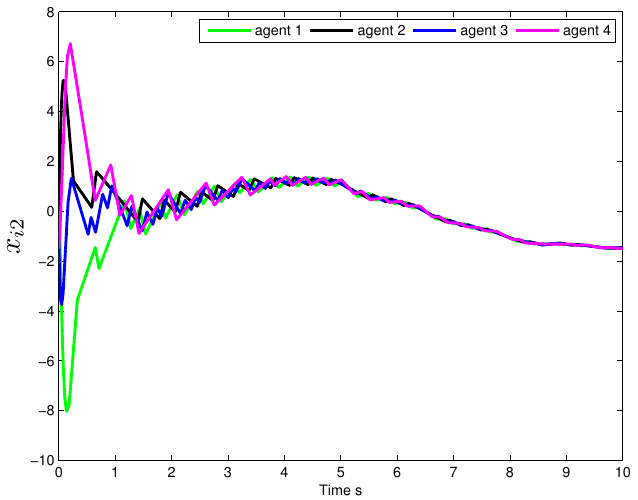
Figure 3. x i 2 ( t ) trajectories of MAS (42) with state-based